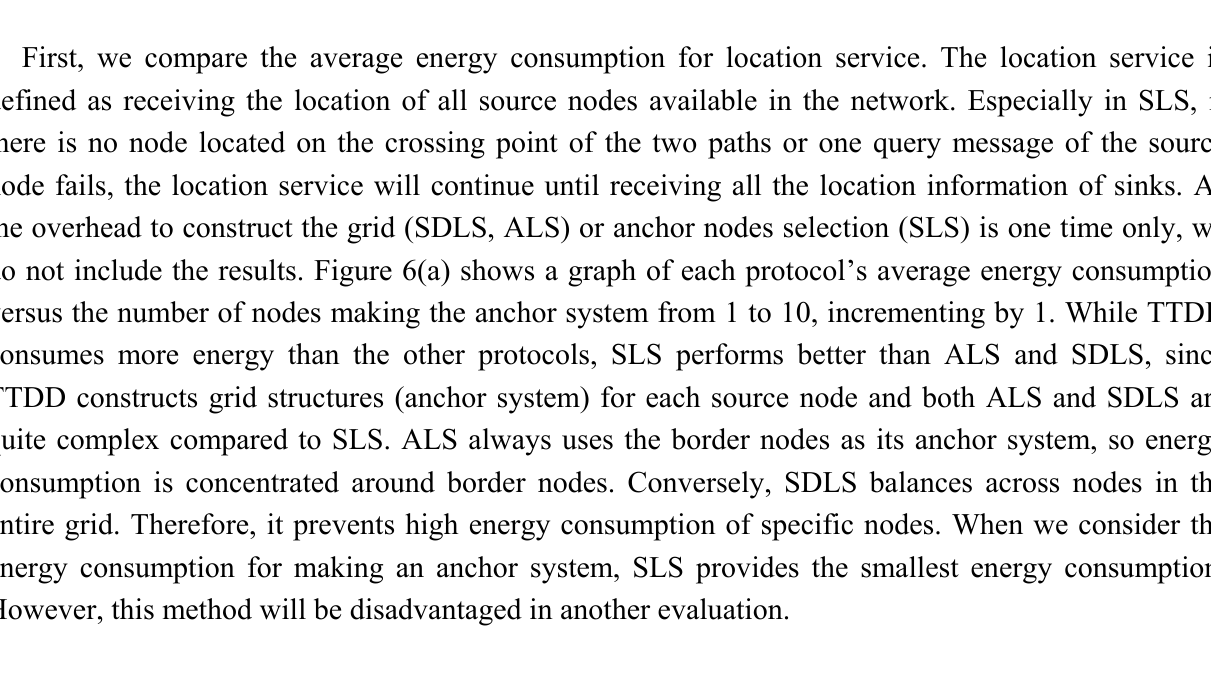
Figure 6. Average energy consumption for location